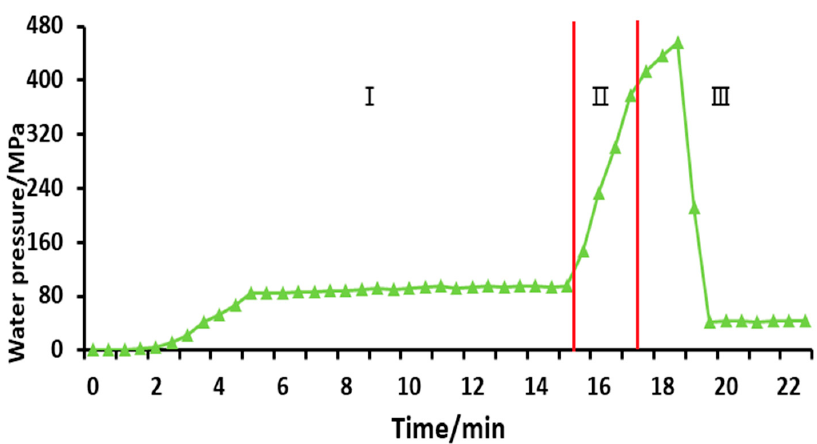
Figure 14. Water pressure variation of aquifuge rock in the process of water inrush of cavity at the bottom of arch.